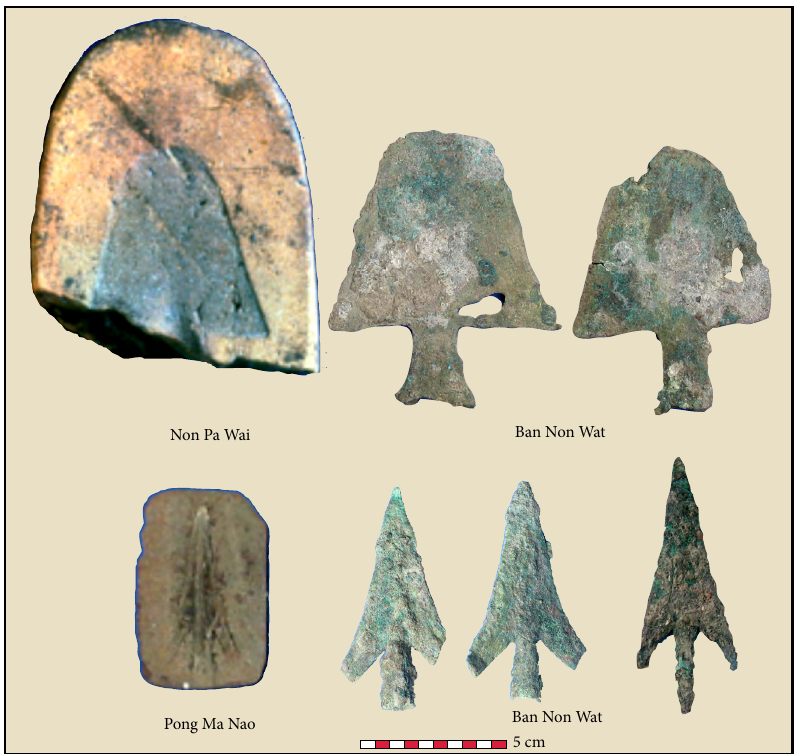
Pong Ma Nao Ban Non Wat 5 cm Fig. 13: Iron Age ceramic moulds from Lopburi sites and corresponding cast artefacts from Ban Non Wat.